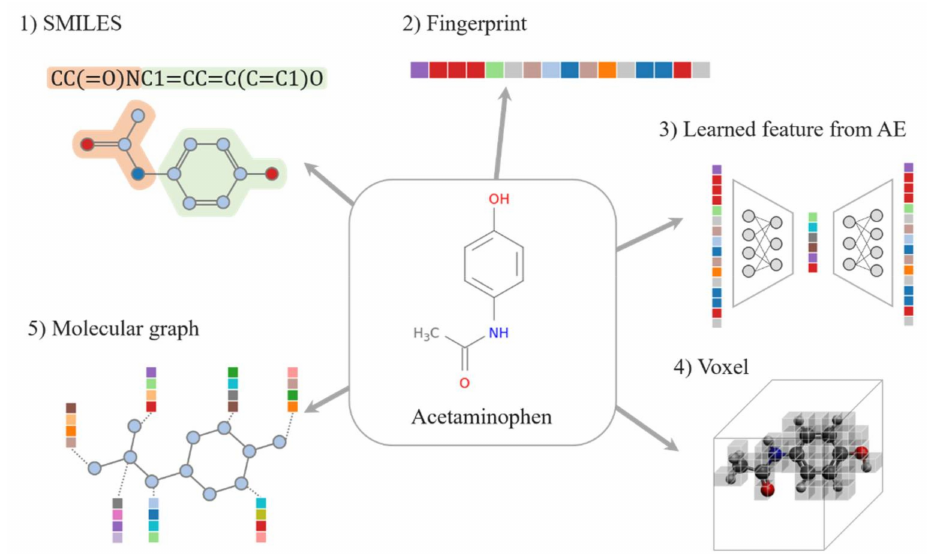
Figure 1. Different types of drug representations used in DL-based drug discovery. This figure shows the drug representations of acetaminophen, which is widely used to treat mild to moderate pain. ( 1 ) SMILES: a string that expresses structural features including phenol group and amide group. ( 2 ) Fingerprint: a 16-digit color-coded 64-bit MACCS key fingerprint. ( 3 ) Learned representations: In this case, it depicts the features learned from an autoencoder (AE). ( 4 ) Voxel: binary volume elements with atoms assigned to a cube with a fixed grid size. ( 5 ) Molecular graph: Each node encodes the network information of the molecular